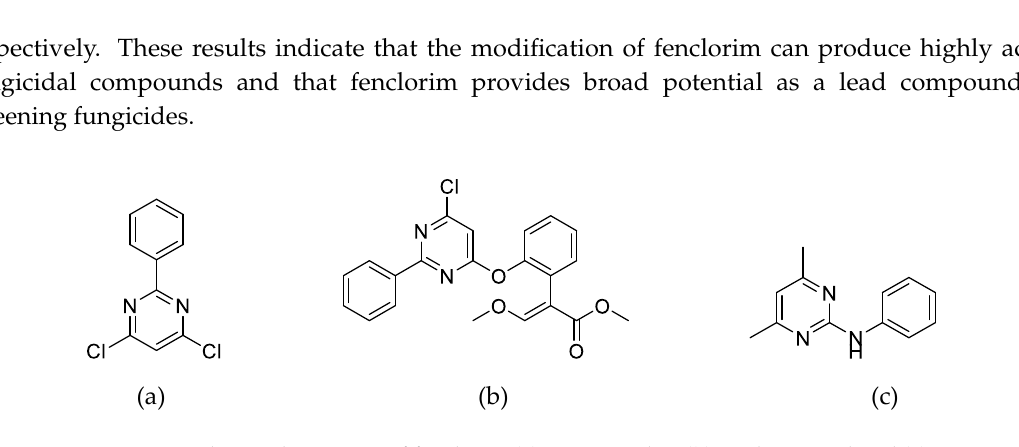
Figure 1. Chemical structure of fenclorim ( a ), azoxystrobin ( b ), and pyrimethanil ( c ).